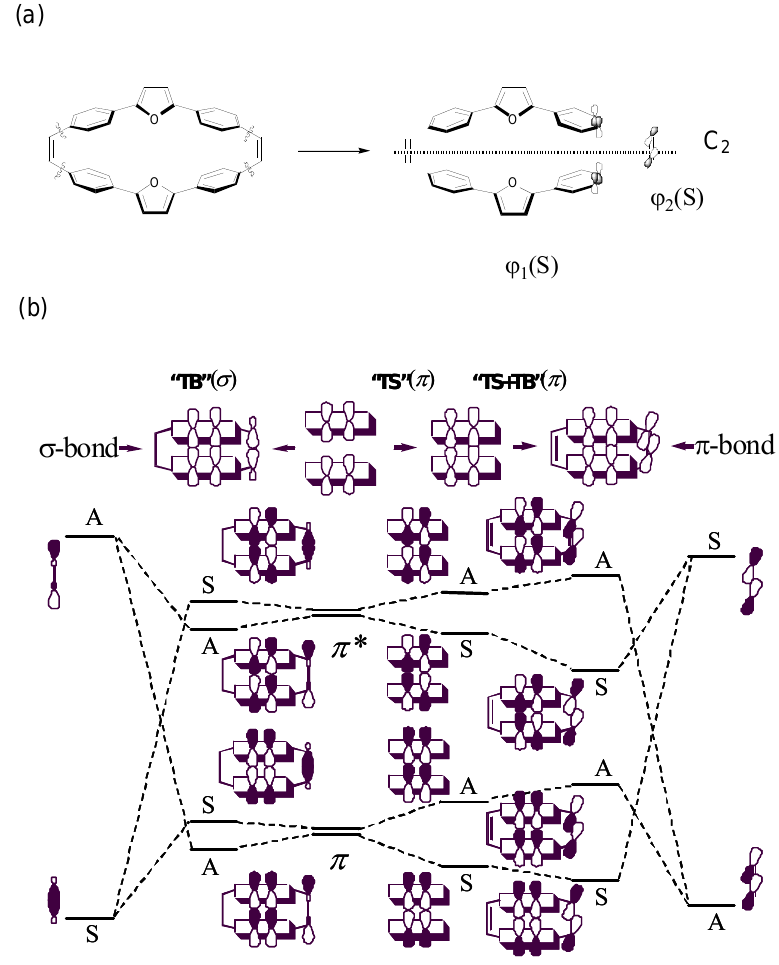
Figure 8. Orbital diagram for “through-space’’ and “through-bond’’ interaction in the class symmetry element [47]. Reproduced with permission from I/II cyclophandienes with C 2 American Chemical